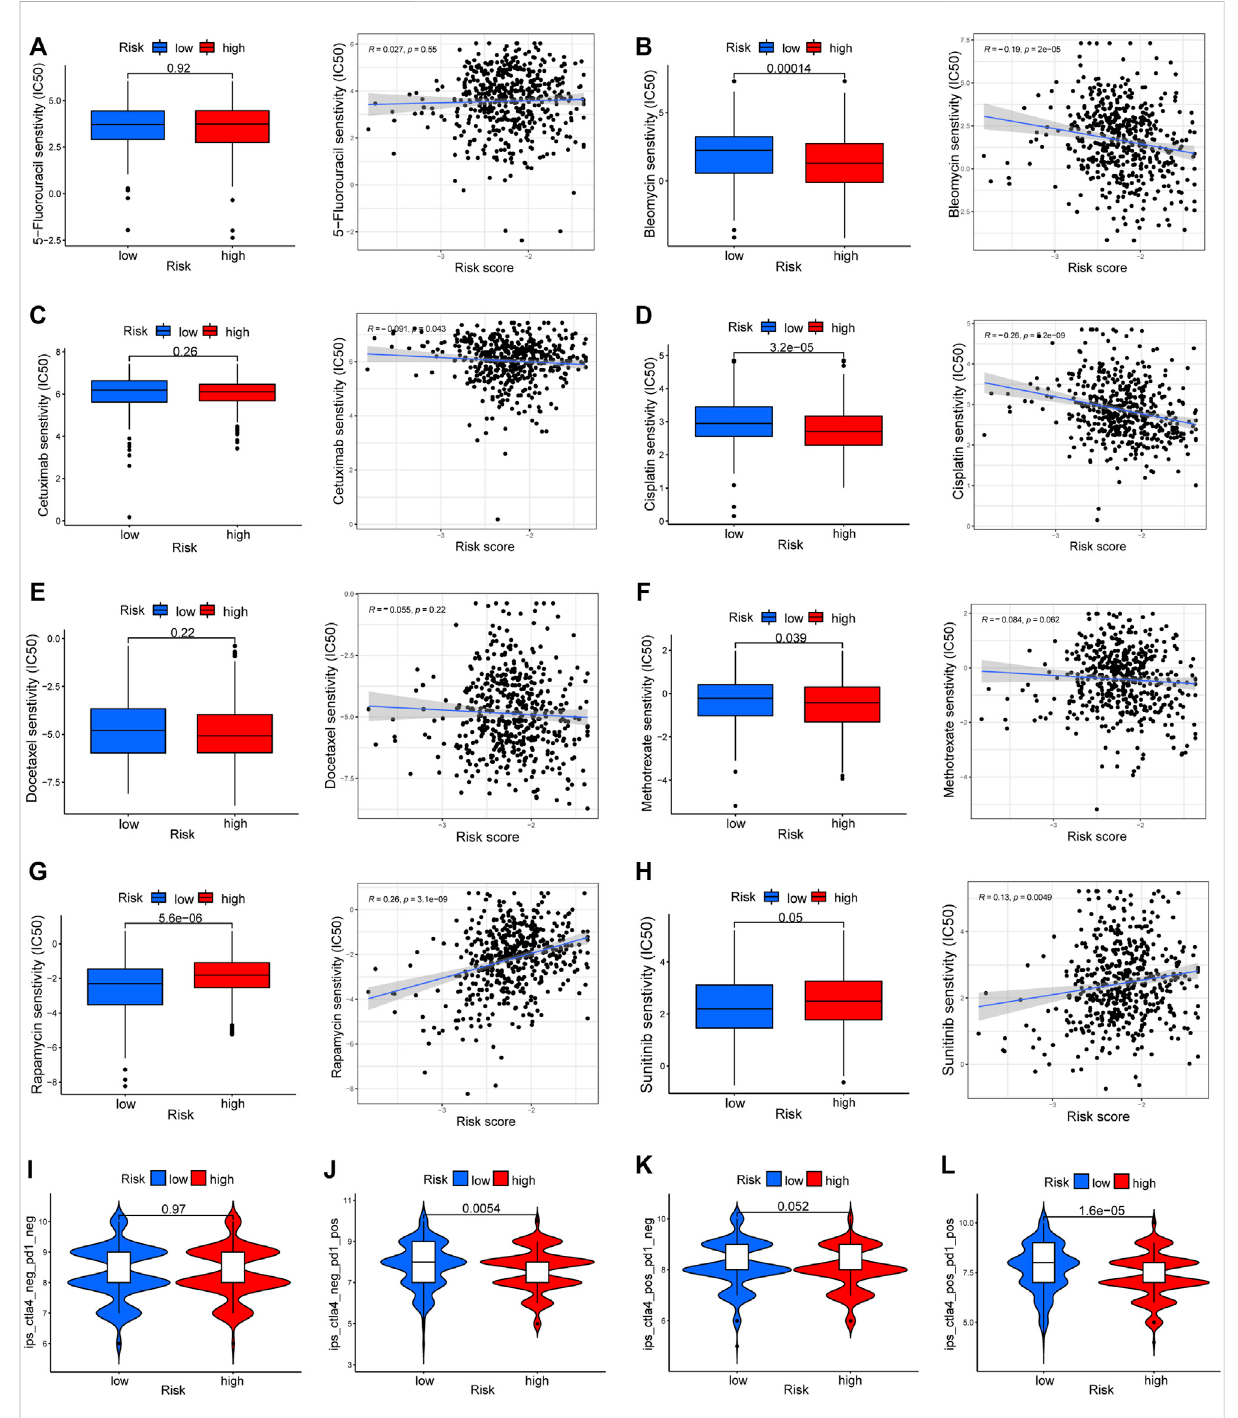
FIGURE 14 Drug response prediction between the two risk groups. (A – H) The IC50 of eight common chemotherapeutic agents (5-Fluorouracil, Bleomycin, Cetuximab,Cisplatin, Docetaxel, Methotrexate,Rapamycin,and Sunitinib) andcorrelationanalysiswith riskscore. (I – L) Thedifferenceof immunophenoscore (IPS) scores among high- and low-risk